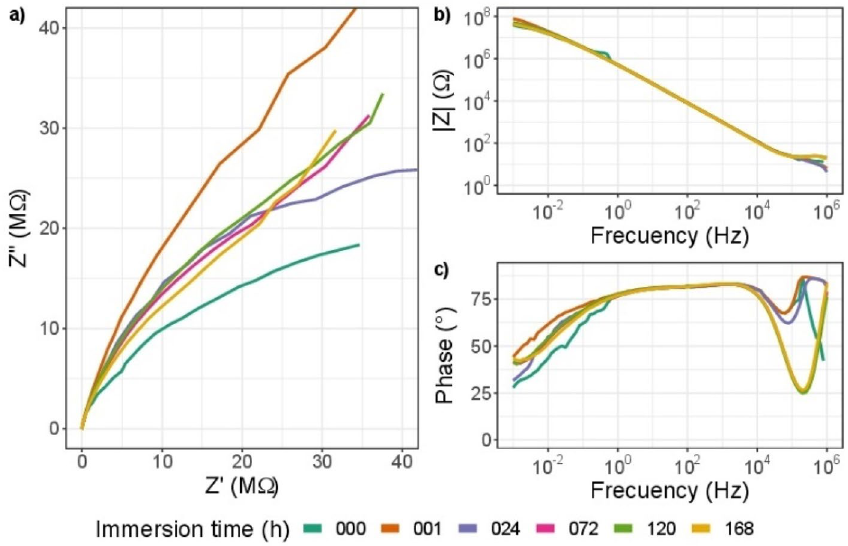
Figure 14. EIS diagram for impedance modulus obtained after different immersion times in 3.5% wt NaCl solution for ZrO